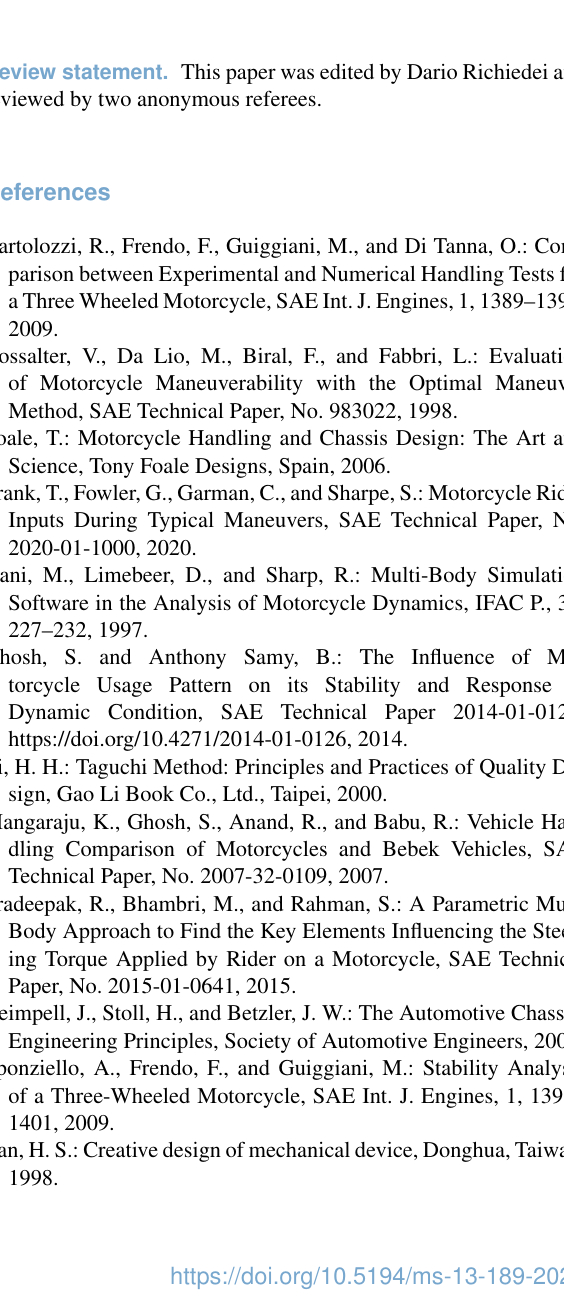
Figure 29. Evaluation index of the obstacle avoidance